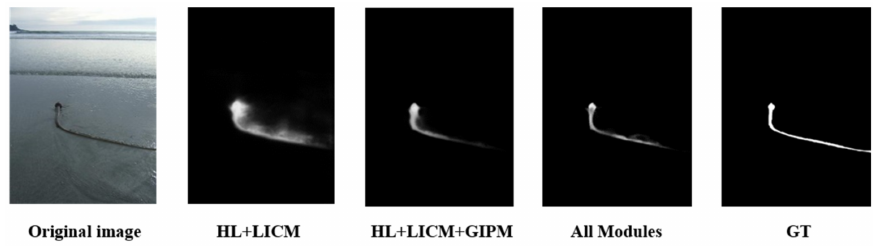
Figure 6. Saliency maps predicted by our proposed DBFFNet with different